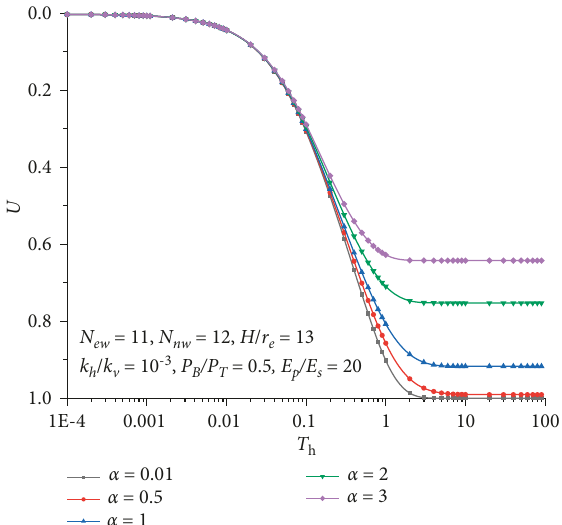
Figure 4: Influence of α on average consolidation degree when only radial flow is considered.